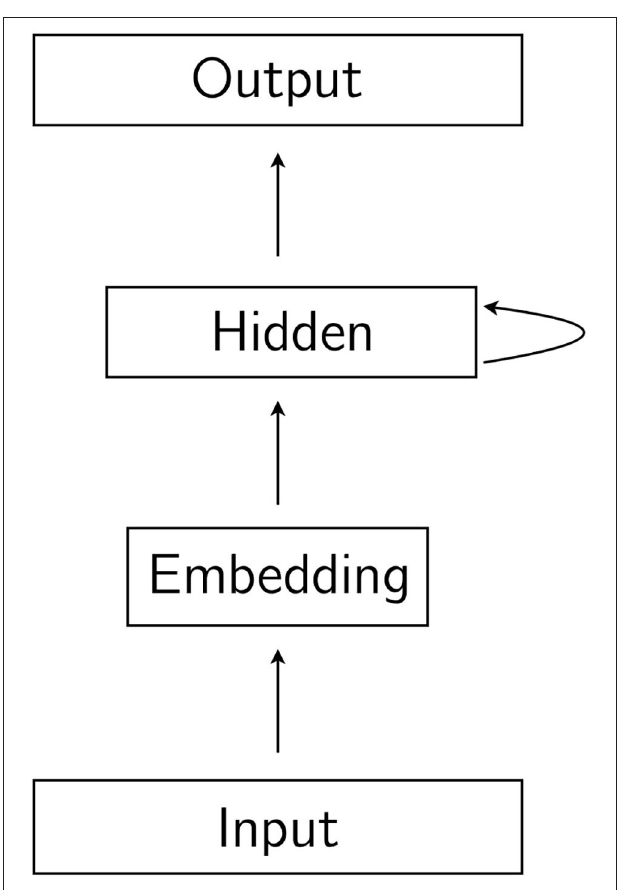
FIGURE 2 | A simple recurrent neural network. The hidden layer receives activation from the embedding layer and from the hidden layer in the previous time